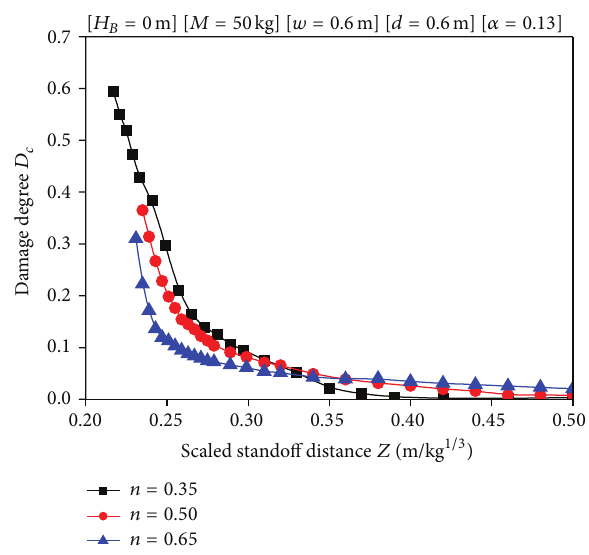
Figure 14: Effects of axial load ratio on the damage